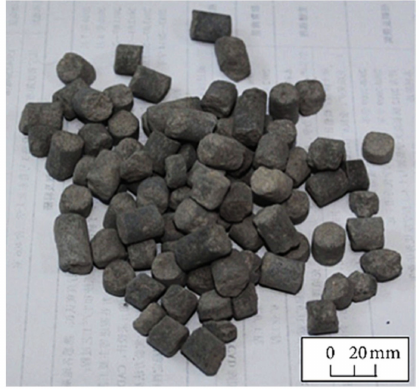
Figure 8. Coal gangue ceramsite